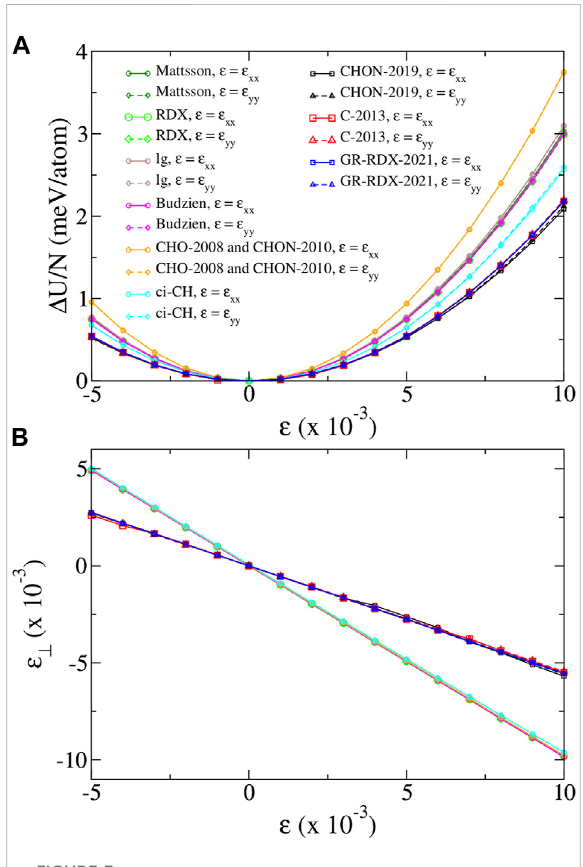
FIGURE 3 (A) Strain energy per atom Δ U / N and (B) transverse strain ε ⊥ , versus strain ε , for uniaxial strain along x and y directions, for the ReaxFF potentials of the present study. For strain along x (arm chair) direction, ε = ε xx , ε ⊥ = ε yy and σ yy = 0. For strain along y (zig-zag) direction, ε = ε yy , ε ⊥ = ε xx and σ xx = 0. Legends of panel (A) apply in both